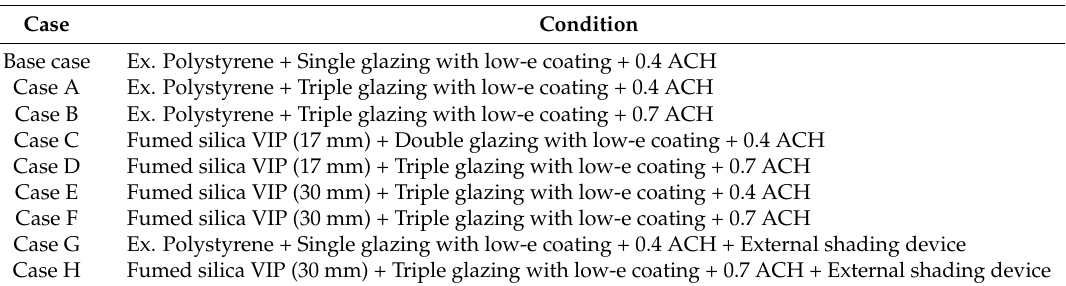
Table 5. The combinations of design alternatives.